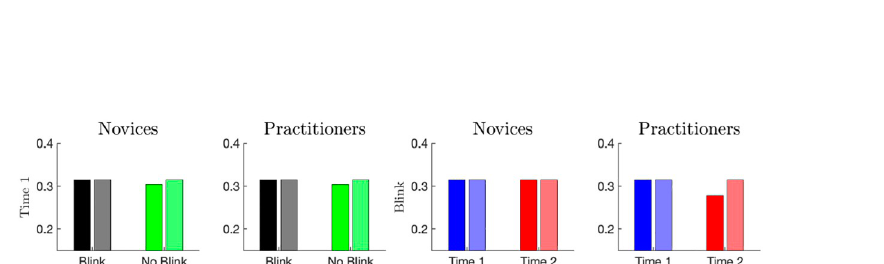
Fig 4. Model behavior in mental noise parameter space. (A) T2 detection probability for a T2-T1 lag of 4. (B) The model P3b amplitude defined in Eq 6, for a T2-T1 lag of 4. (C) lag-1 sparing probability as a function of mental noise activity parameters (mean and variance). The color indicates the probability of crossing the blinking threshold at lag 2 but not at lags 1 and 5. Blue and red crosses indicate ( μ , σ ) values at time 1 and 2 respectively, for which the model reproduces lag-1 sparing as well as the main findings of Slagter et al. [2], namely an increase of in T2 detection accuracy from 0.6 ± 0.1 at time 1 to 0.8 or higher at time 2, and a reduction in T1-evoked P3b amplitudes by a factor of of 1.25–2. The green arrow connects the pair of mental noise parameter values at time 1 and 2 corresponding to the effects of mental training shown in Fig 5 below.